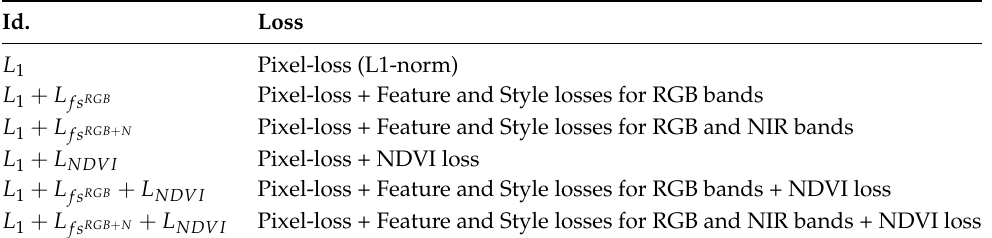
Table 3. Loss functions considered in the experiments and their identifiers.